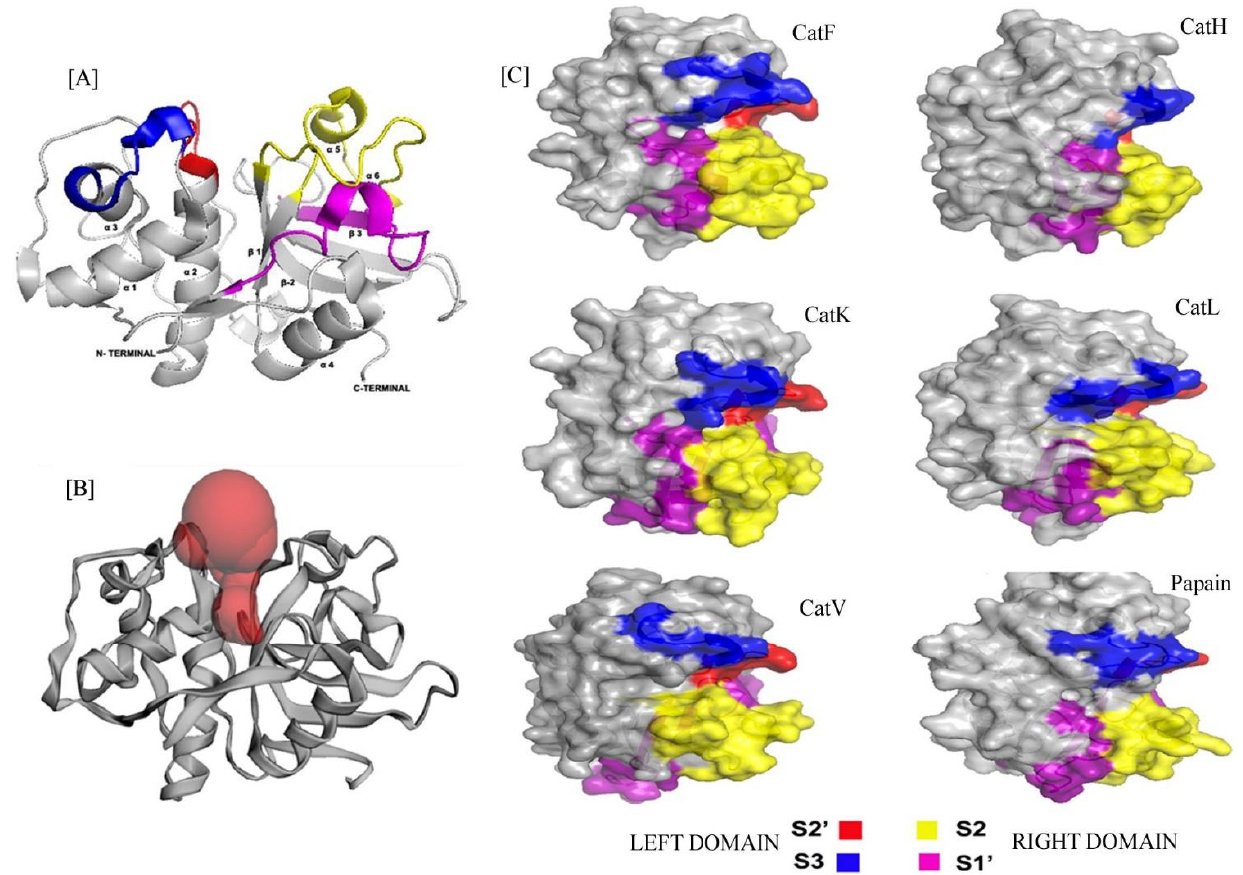
Figure 1. ( A ) Cartoon representation of Cathepsin with Left (L) and Right (R) domains consisting substrate binding subsites S2 (cid:48) (red), S3 (blue) and S2(yellow), S1 (cid:48) (pink) respectively. The N-terminal L-domain contains mostly α -helix whereas the C-terminal R-domain with mostly β -sheets. The image was prepared by PyMOL. ( B ) The cartoon structure of protein is showing the position of active site cleft at the mid-point of L- and R-domain. The red spheres indicating the presence of binding pocket at this site. The image was created by Computed Atlas of Structure Topography of proteins (CASTp). ( C ) Surface structures of all the cathepsins are showing their structural similarity with papain, comprising S2 (cid:48) (red), S3(blue) substrate binding sites at Left (L) and S2 (yellow), S1 (cid:48) (pink) substrate binding sites at Right (R) domains. All the images were created by using